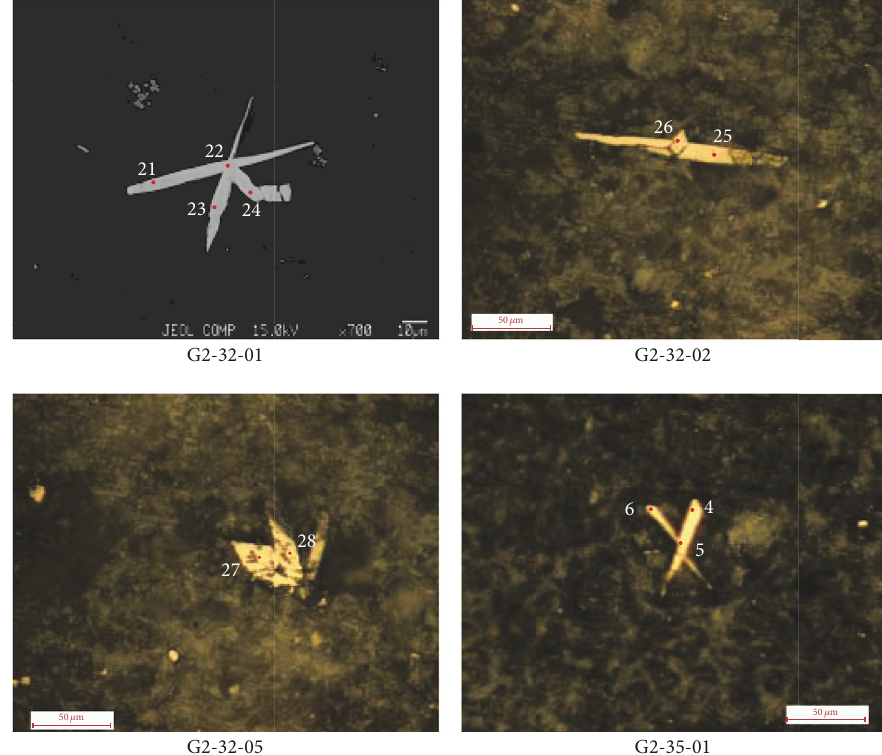
Figure 6: Microphotographs showing the structures of arsenopyrite . EPMA analysis points are marked by red dots and the data are given in Table 3. The black-and-white images are EPMA BSE images, while the color images were taken under reflected